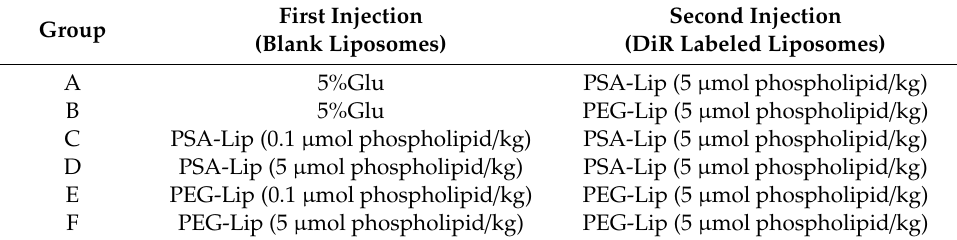
Table 1. The injection scheme of PSA-Lip and PEG-Lip in wistar rats.